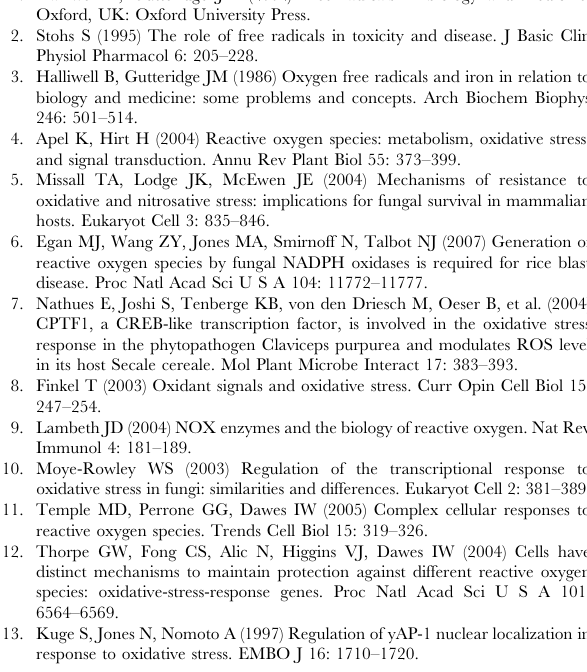
Figure S6 Detection of cell death in A. brassicicola wild-type and D tmpL conidia stained with annexin V-FITC. (A) Conidia collected from 7- and 21-day-old fungal colonies grown on solid CM were subjected to annexin V-FITC staining. Percentage of conidia showing fluorescence that are classified as dead cells was measured. Columns and error bars represent average and SD, respectively, of two independent experiments. (B) Representative micrographs showing an annexin V-FITC positive conidial cell of the 21-day-old Ab D tmpL mutant, while no staining in the 21-day- old wild-type conidia. Figure S7 Formation of appressoria and infection hyphae and a virulence assay of wounded and non-wounded green cabbage leaves inoculated with A. brassicicola wild-type and D tmpL mutant. (A) Green cabbage cotyledons were used to examine the appressoria and infection hyphae formation of wild-type and Ab D tmpL mutant infection. Intracellular infection hyphae of the Ab D tmpL mutant were rarely developed inside of the plant epidermal cells, while infection hyphae of the wild-type appressoria were consistently observed. Bars = 20 m m. Abbreviations: a, appresso- rium; ih, infection hypha. (B) Green cabbage leaves inoculated with wild-type and Ab D tmpL mutant were collected at 12 and 24 hpi, embedded epoxy resin, sectioned, and stained with 0.1%